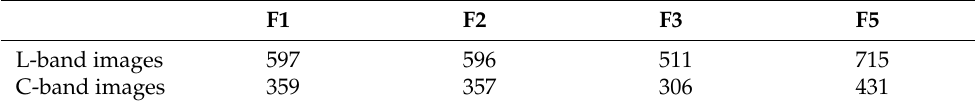
Table 6. Pixels number of each polygon for the forested sites F1, F2, F3, and